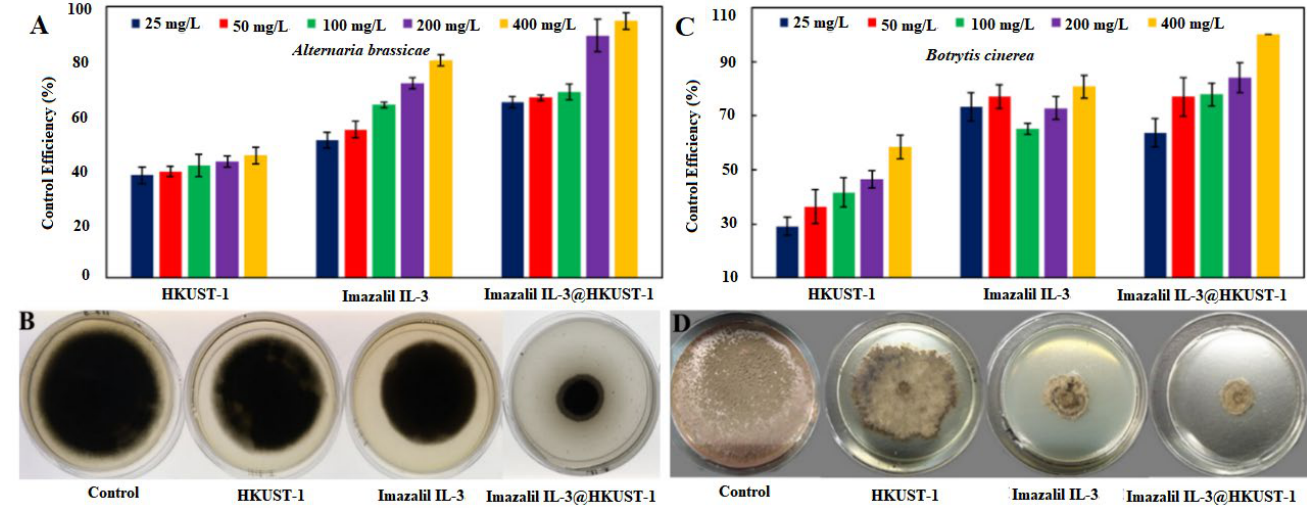
Figure 2. Control efficiencies of HKUST-1, imazalil IL-3 and imazalil IL-3@HKUST-1 against Al-ternaria brassicae ( A ) and Botrytis cinerea ( B ); The effects of the same concentration of HKUST-1, imazalil IL-3 and imazalil IL-3@HKUST-1 on the mycelia growth inhibition rates of Alternaria brassicae ( C ) and Botrytis cinerea ( D ).